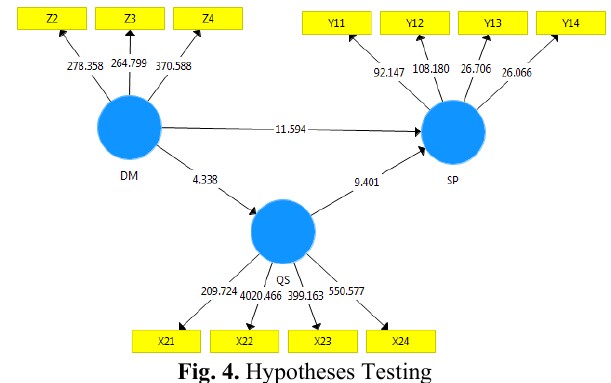
Fig. 4. Hypotheses Testing